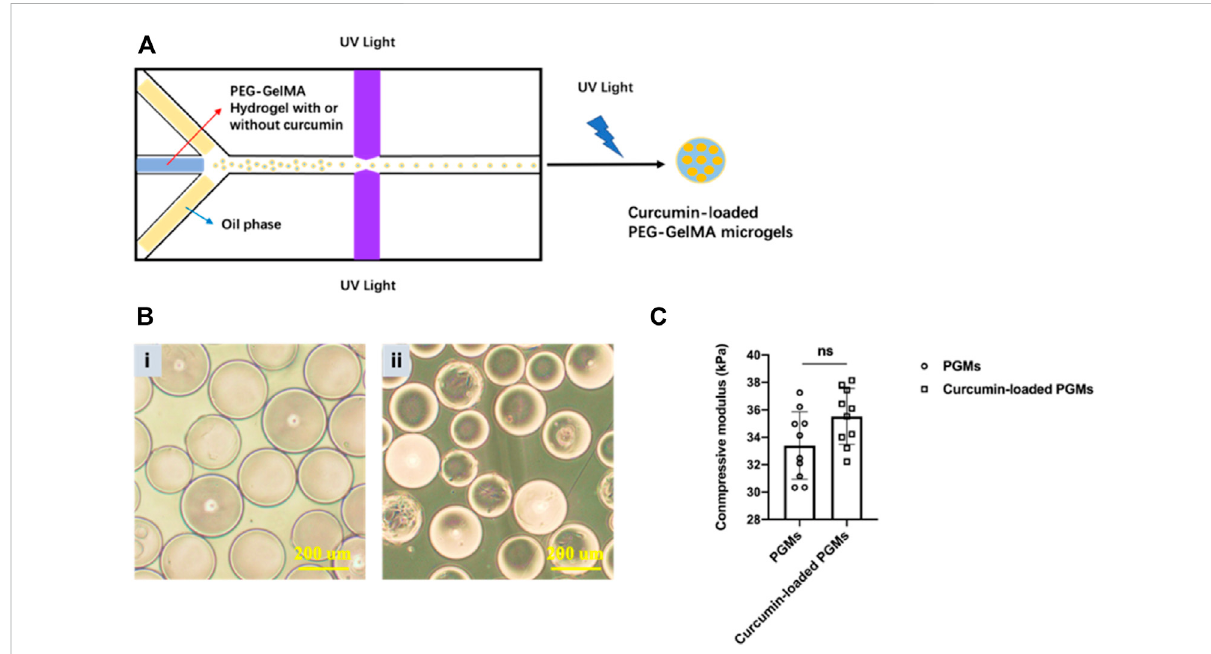
FIGURE 1 Curcumin-loaded PEG-GelMA microgel (PGMs) synthesis and characterization. (A) Schematic illustration of PEG-GelMA microgel fabrication by micro fl uidic technology. (B) The microscopic images at bright fi eld of PGMs (i) and curcumin-loaded PGMs (ii), Scale bar = 200 μ m. (C) The compressive modulus of PGMs and curcumin-loaded PGMs, respectively. N = 10